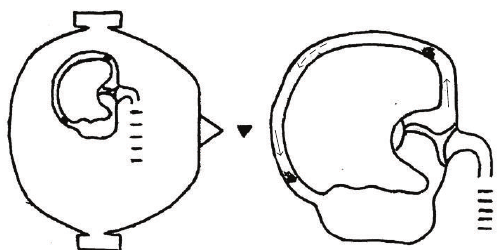
Figure 2: When the patient in supine position rolls his/her head by 180 ◦ from the left to the right side for the third time, pushed by the endolymphatic flow (dashed arrow), some of the debris moves into the posterior arm of the canal, while another part remains in the anterior arm, both moving in an ampullofugal way (thin arrows), thus triggering a right beating geotropic nystagmus (head